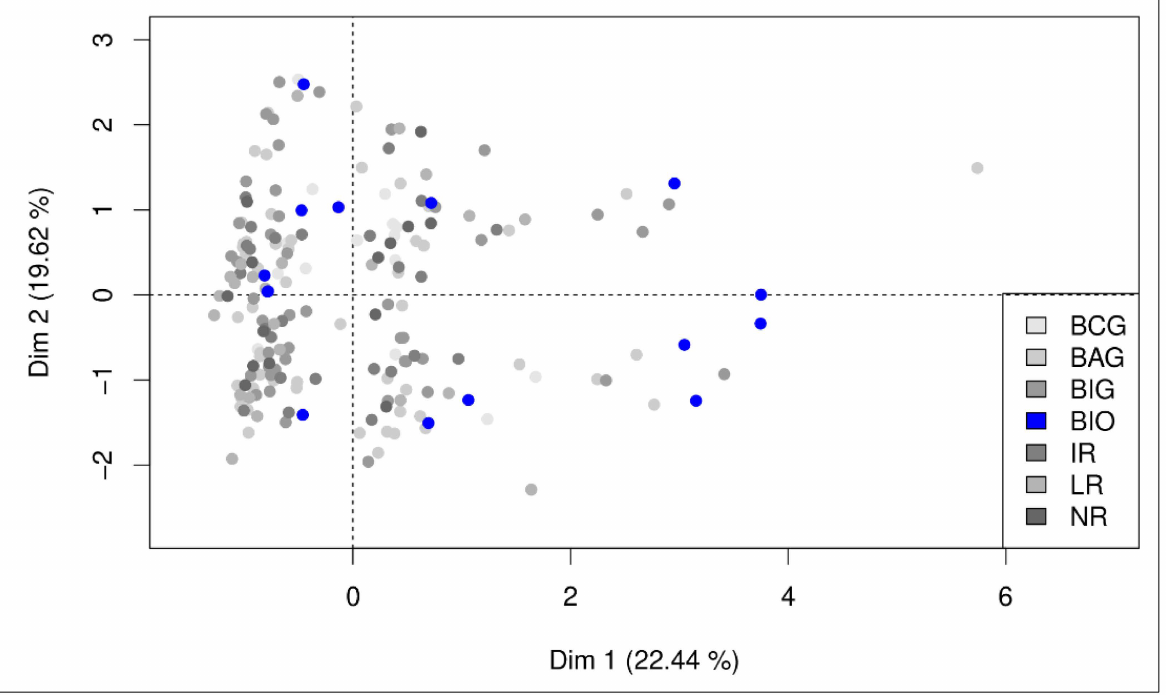
Figure 6. Observation map of mixed principal component analysis of pre-treatment samples using age and CD20 expression levels as continuous variables and Binet stage, IGHV mutational status, trisomy 12, and therapy strata as categorical